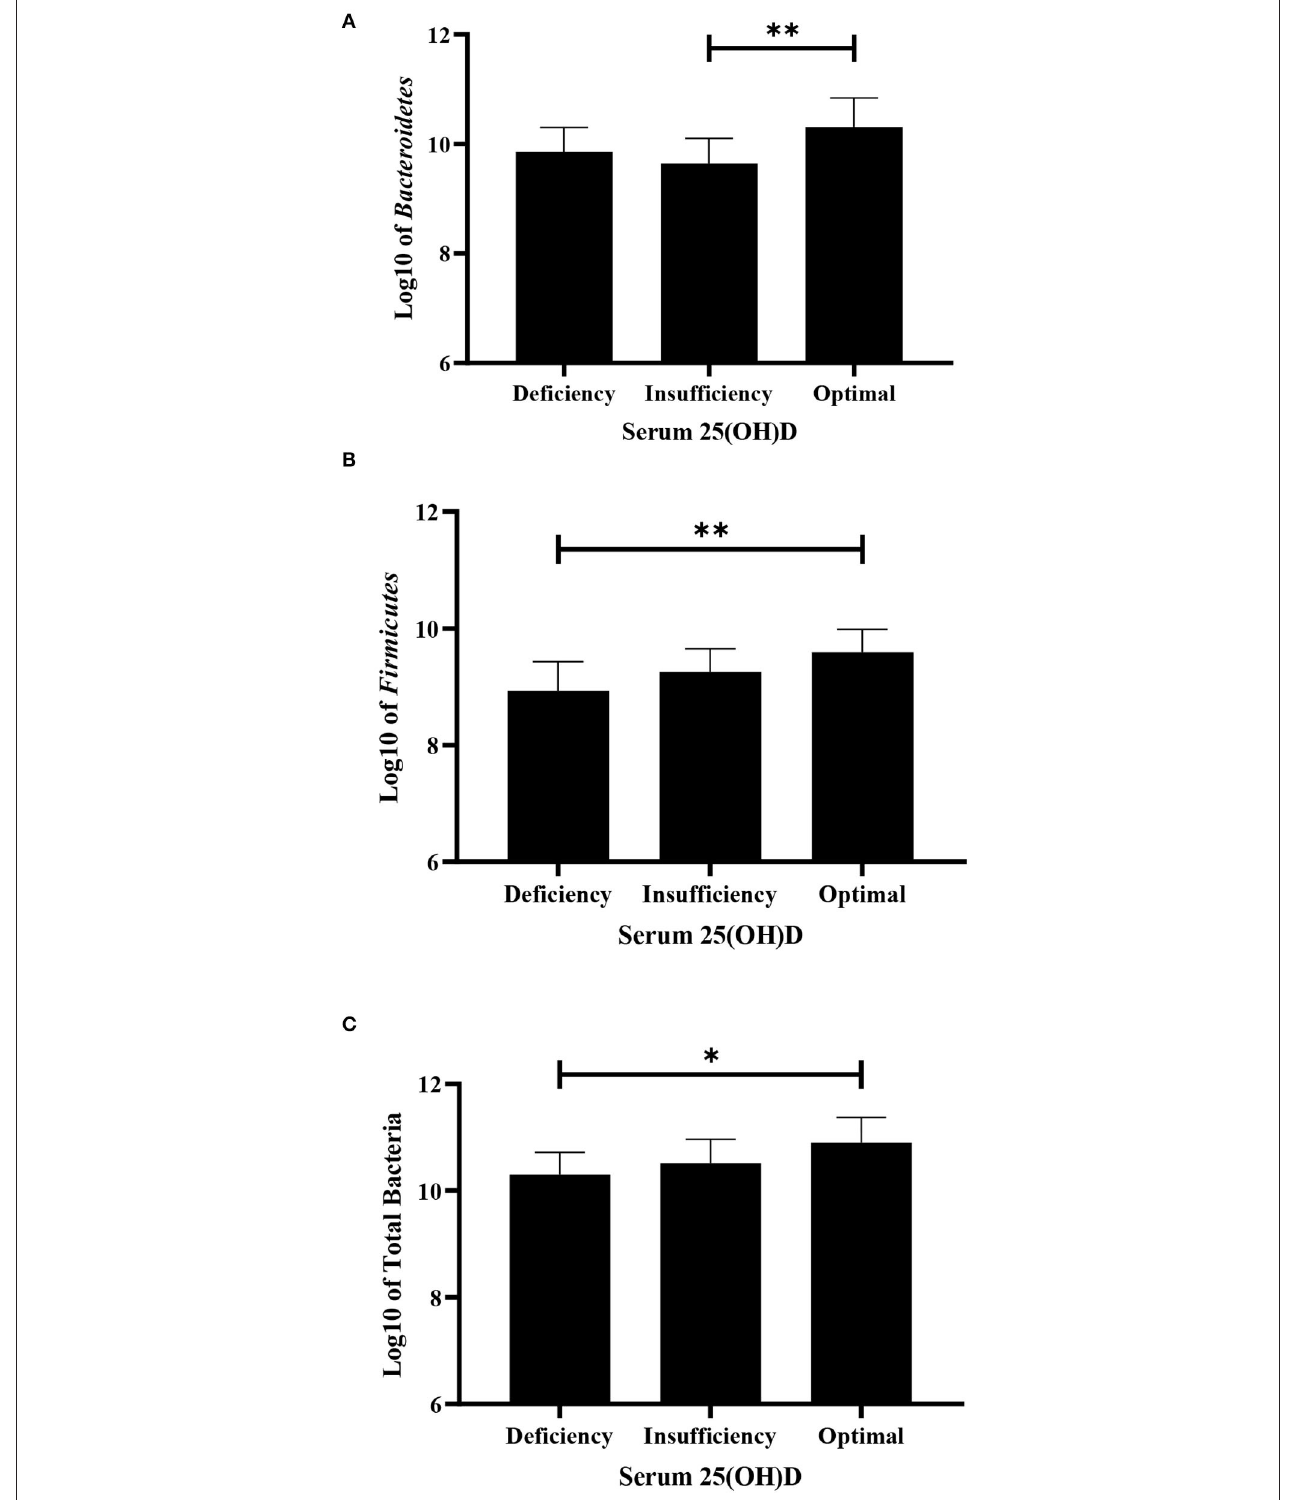
FIGURE 2 | Difference in fecal bacteria strains among deficiency, insufficiency, and optimal serum vitamin D in children with CF using ANOVA. (A) Bacteroidetes . (B) Firmicutes . (C) Total bacteria in children with CF. Values are shown as mean and SD of log-transformed genome copies/g of fecal sample. * P < 0.05; ** P < 0.005.